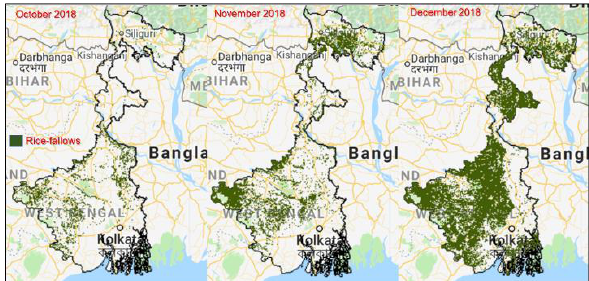
Fig. 2. Mapping real-time rice-fallows in 2018 for supporting pre-planting decision making for pulse intensification in the state of West Bengal,